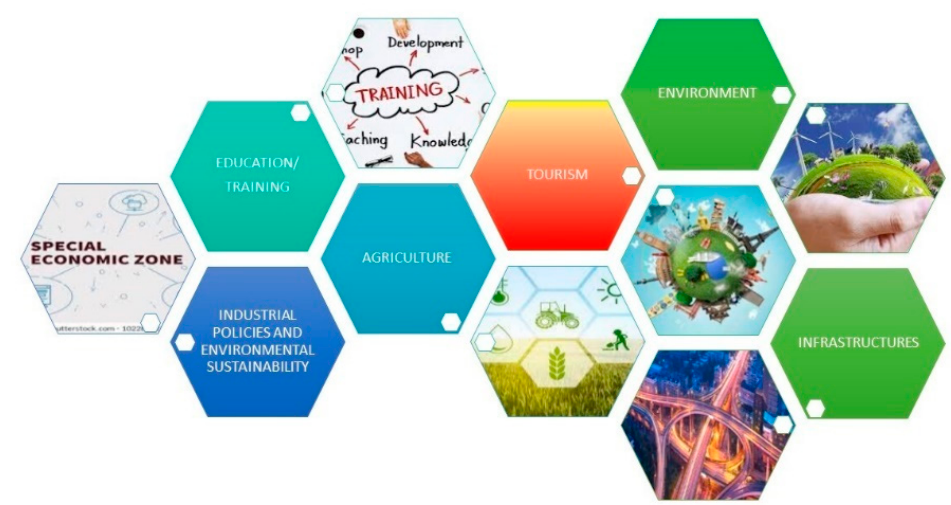
Figure 9. The individuated priority challenges by the participatory planning .